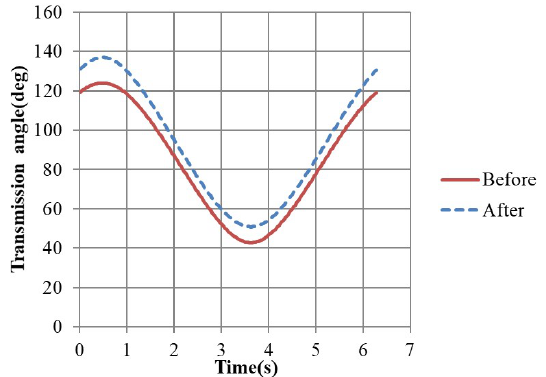
Figure 18. The transmission angle 4  of the driver side output-link of CDLS before/after DE op-